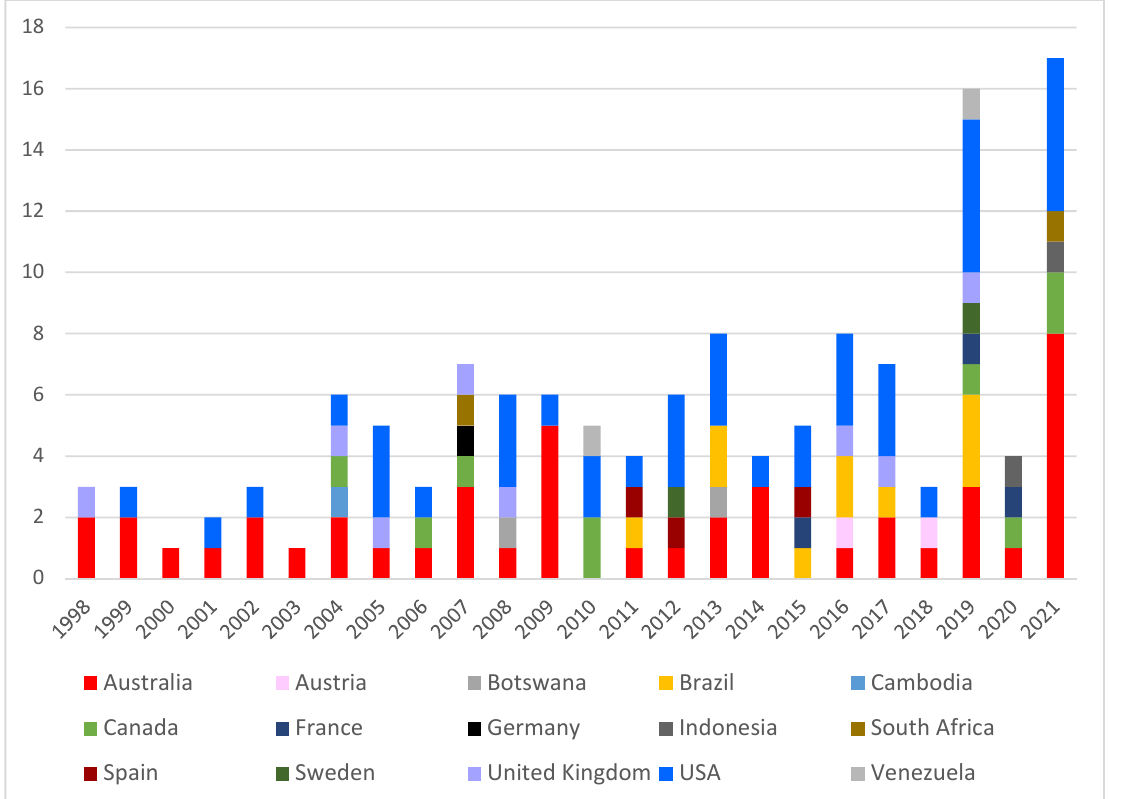
Figure 2. Publication figures by year according to first-author affiliation country.